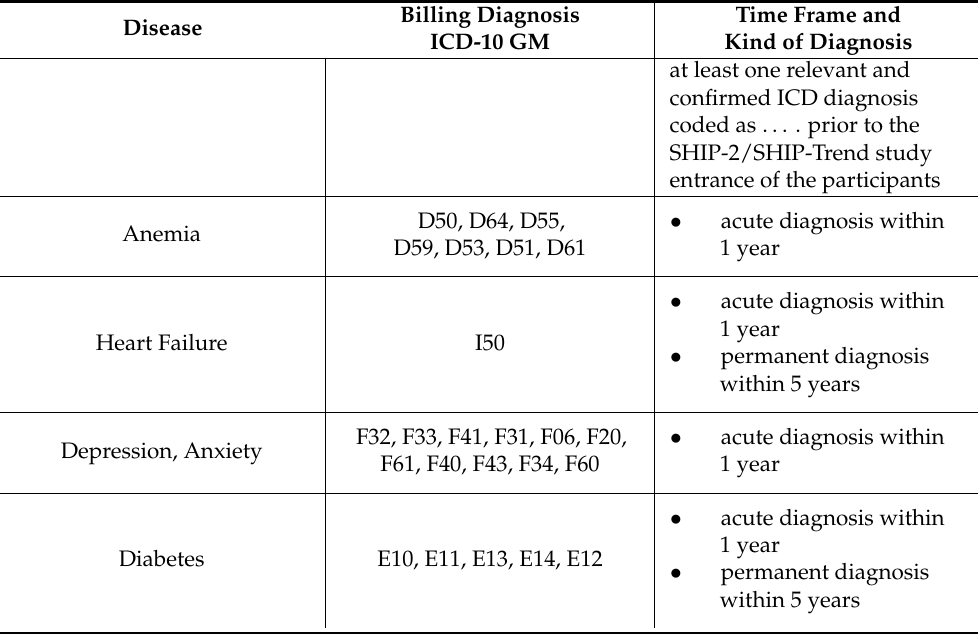
Table 1. Definitions of diseases according to claims